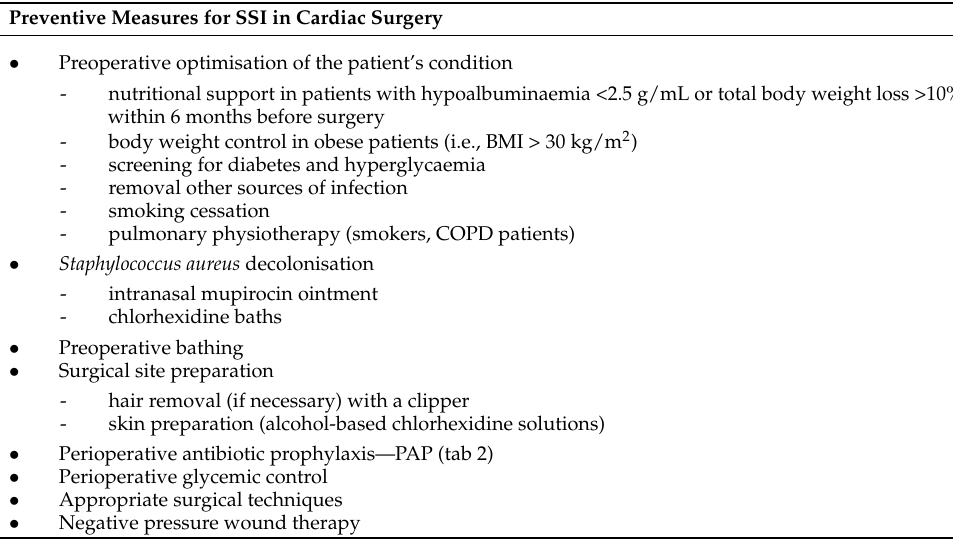
Table 1. The preventive measures for SSI in cardiac surgery. Preventive Measures for SSI in Cardiac